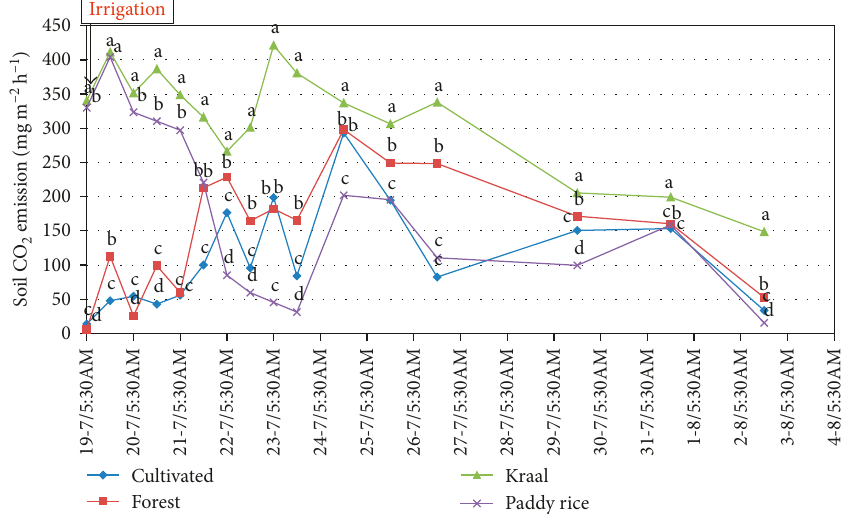
Figure 4: Temporal CO 2 emission from different land-use at Kpong